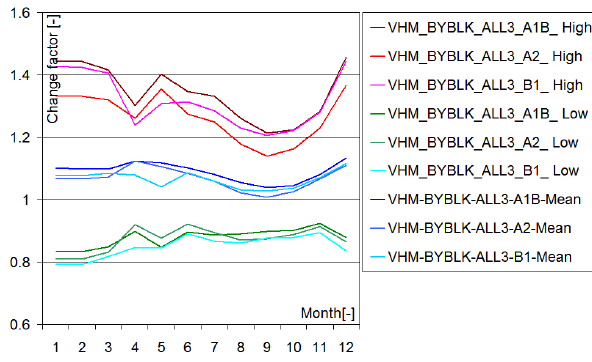
Fig. 15. The high, mean, and low level of impact results on the mean monthly flows at BYBLK after VHM